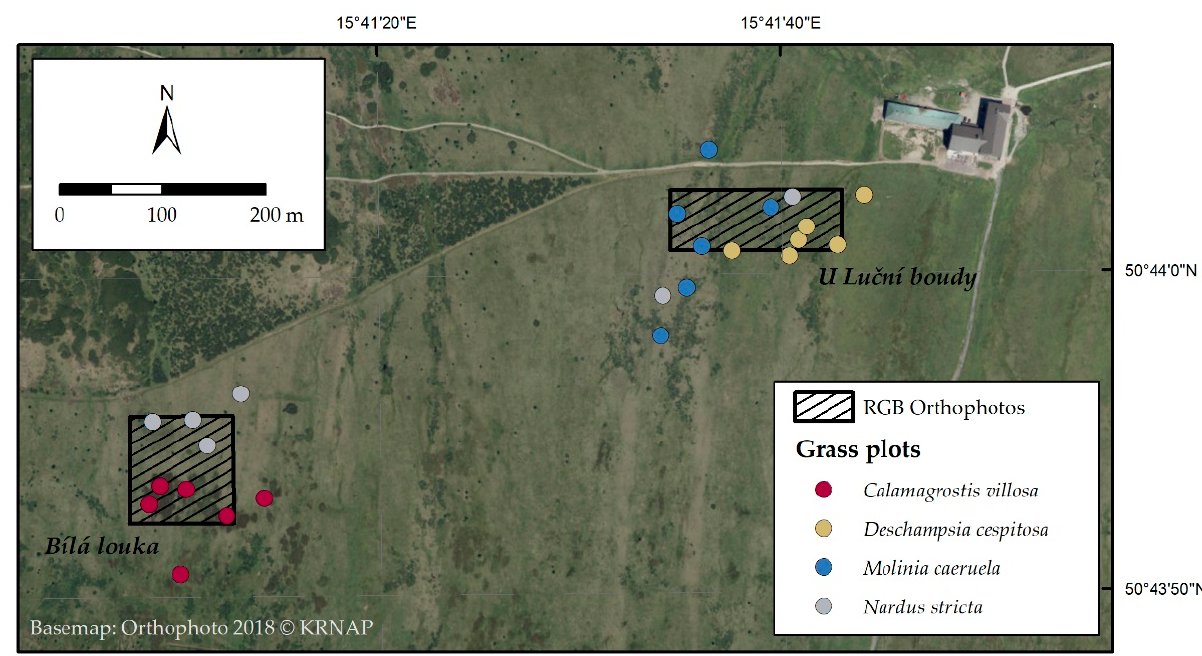
Figure 11. A map of studied area showing the location of sampling plots and two areas where the RGB orthophotos were classified (adapted from Č ervená et al., 2022 [101]).